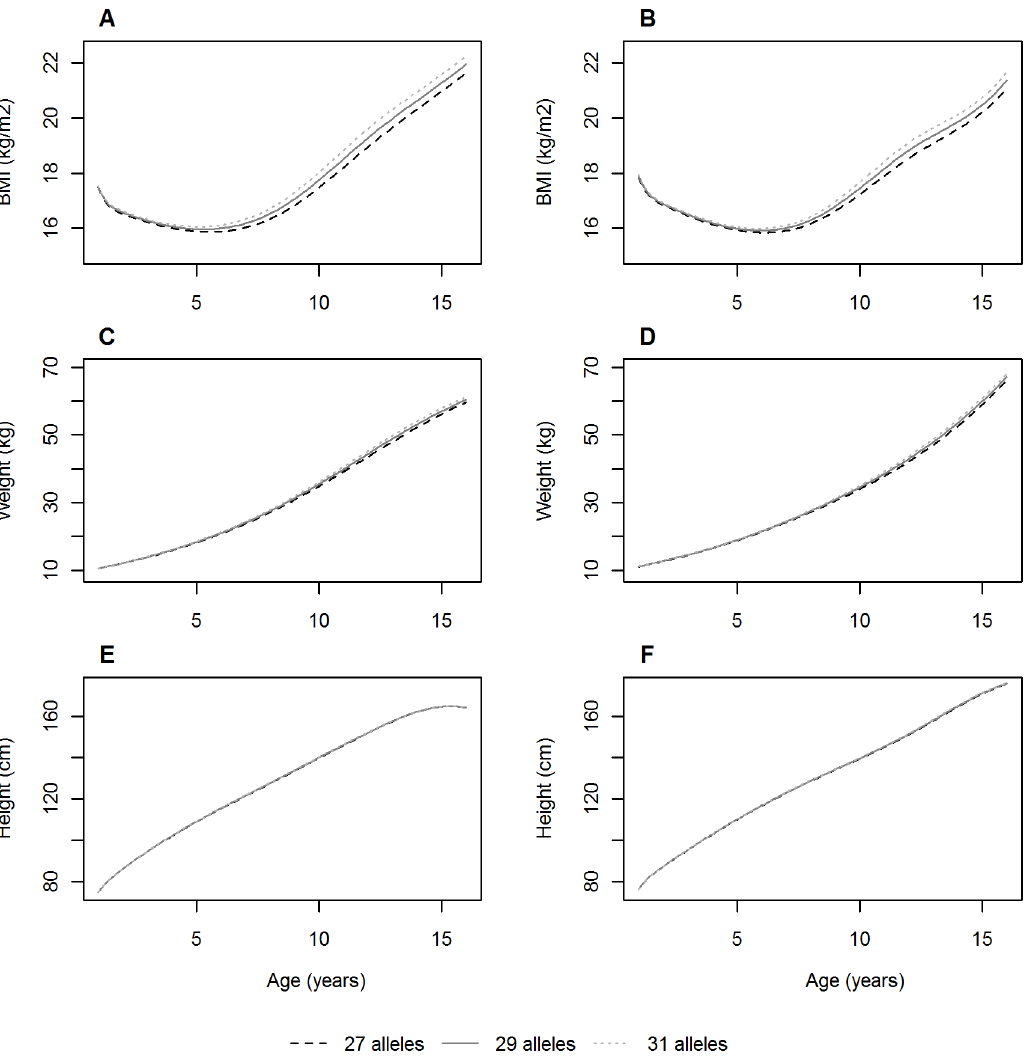
Figure 1. Population average curves for individuals with 27, 29 or 31 BMI risk alleles in females (A, C and E) and males (B, D and F) from the ALSPAC cohort. Predicted population average BMI (A and B), weight (C and D) and height (E and F) trajectories from 1 – 16 years for individuals with 27 (lower quartile), 29 (median), and 31 (upper quartile) BMI risk alleles in the allelic score.